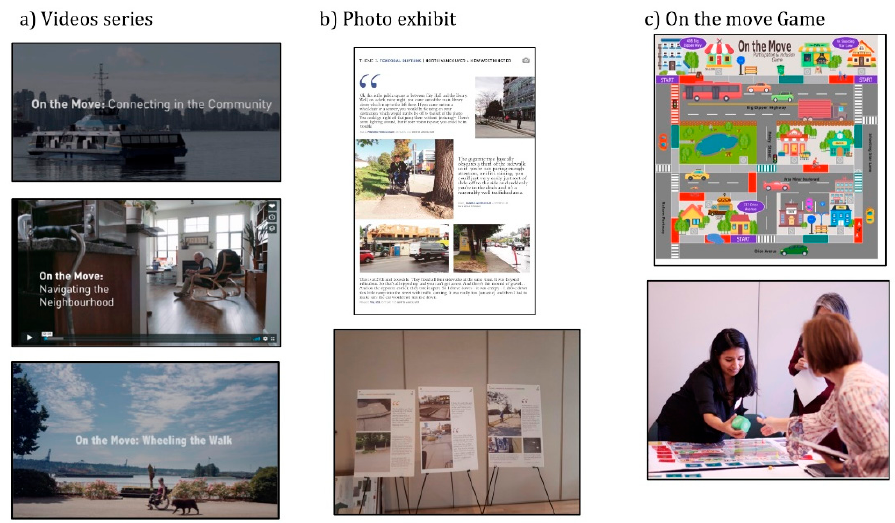
Figure 1. Knowledge Mobilization Strategies.